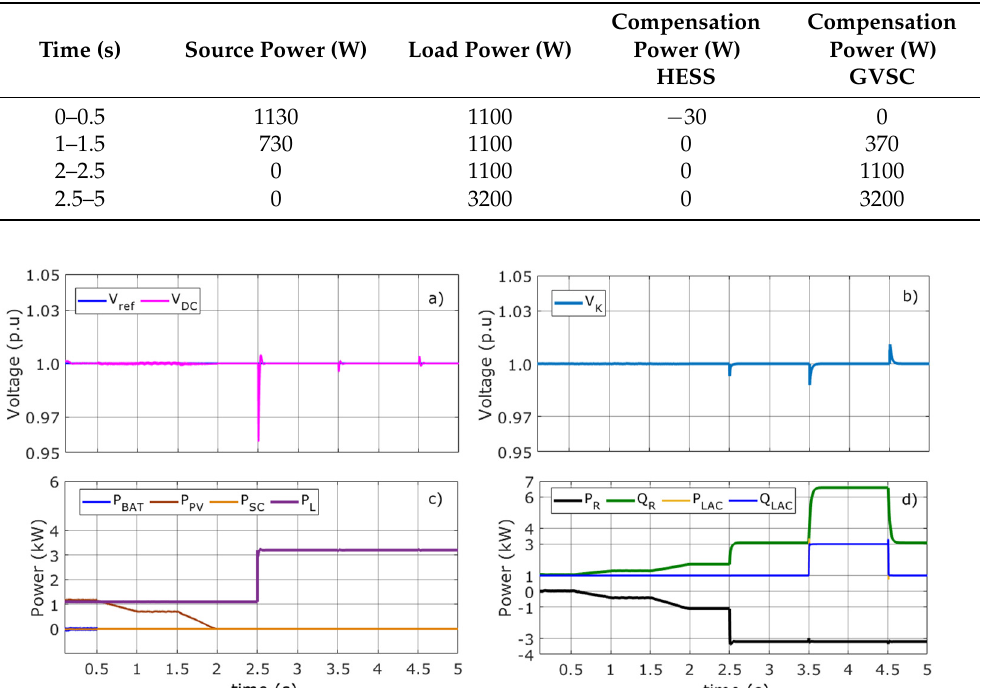
Table 4. Mode of operation 3.